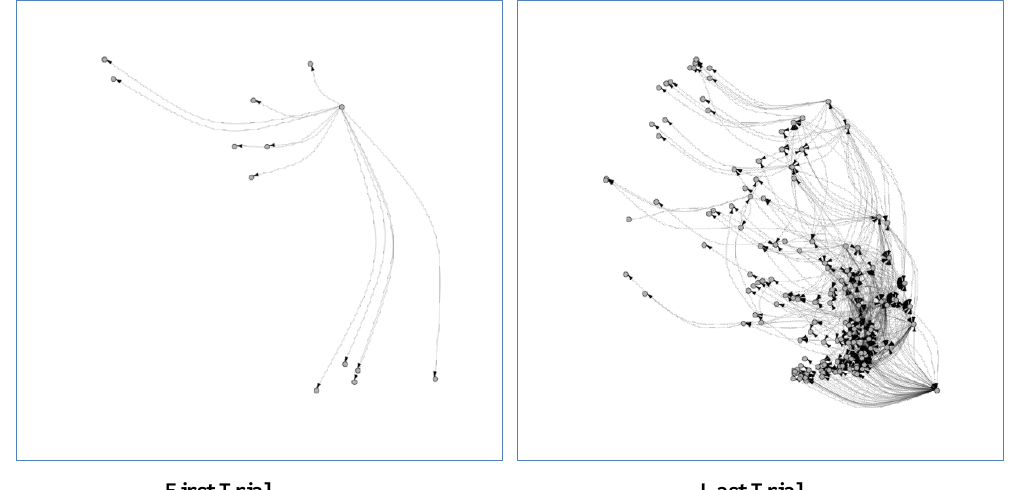
Figure 1: Informing Network in the First and Last